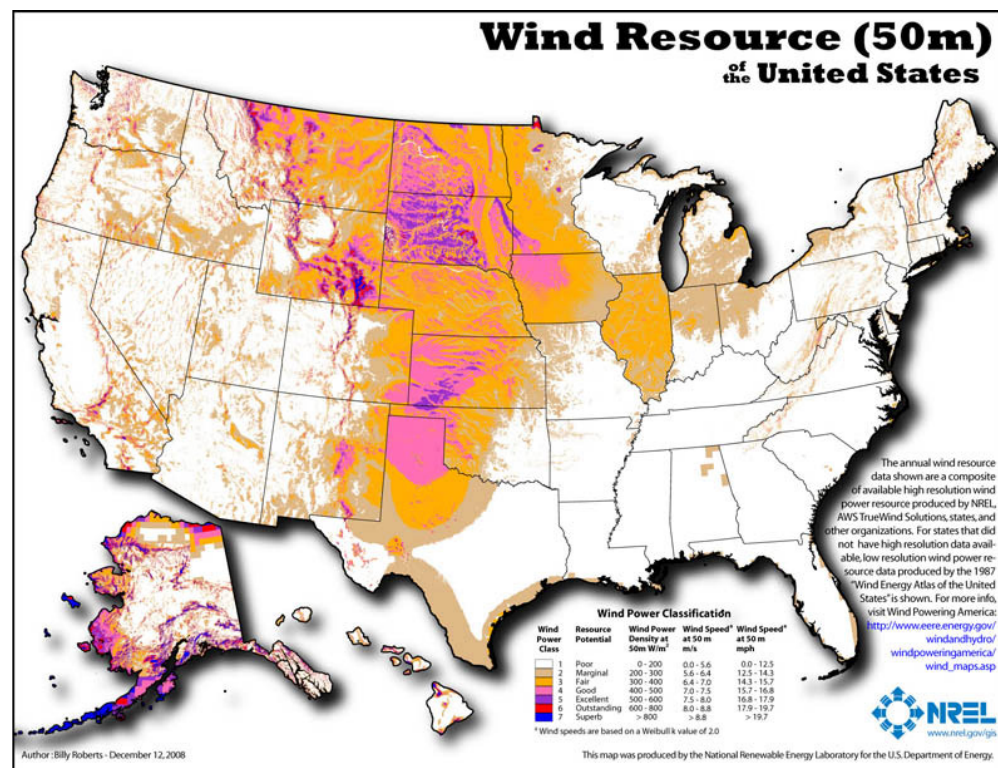
Fig. 8b. US WPD map at 50m developed by NREL.